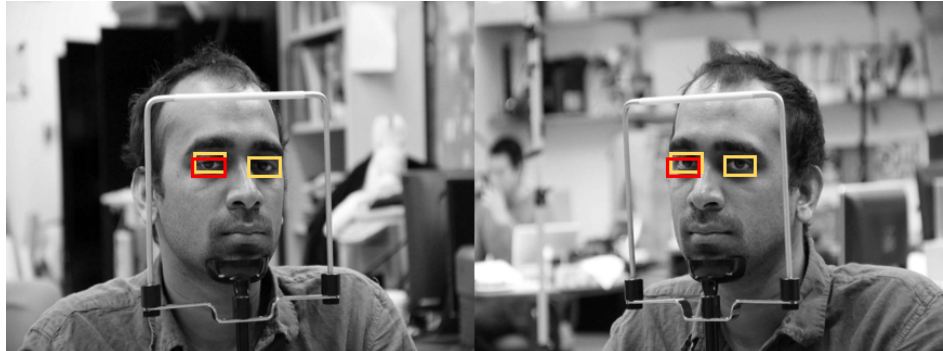
Figure 26. Example of incorrectly detected eye by proposed method (Yellow and red rectangles show the ground-truth and detected boxes, respectively). Table 11. Comparisons of recall, precision, and processing time of the proposed and previous methods at an IOU threshold of 0.5.